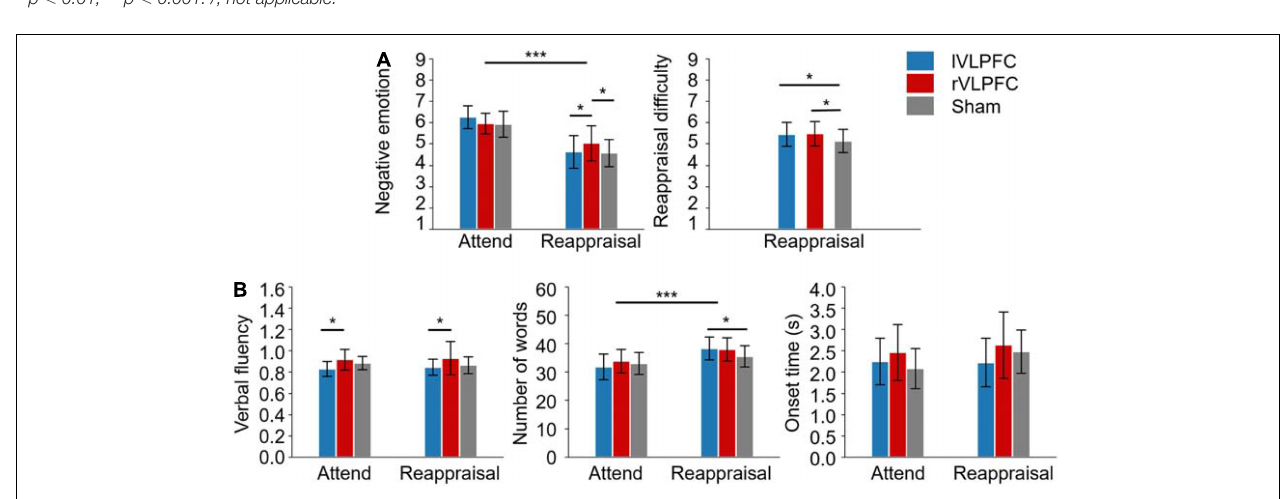
FIGURE 3 | Results of the experiment. (A) Self-reported ratings of negative emotion and reappraisal difficulty. (B) Measures of oral reporting. The subplot in the right corner shows the onset time of oral reporting. Error bars represent ± SD. * p < 0.05; *** p <